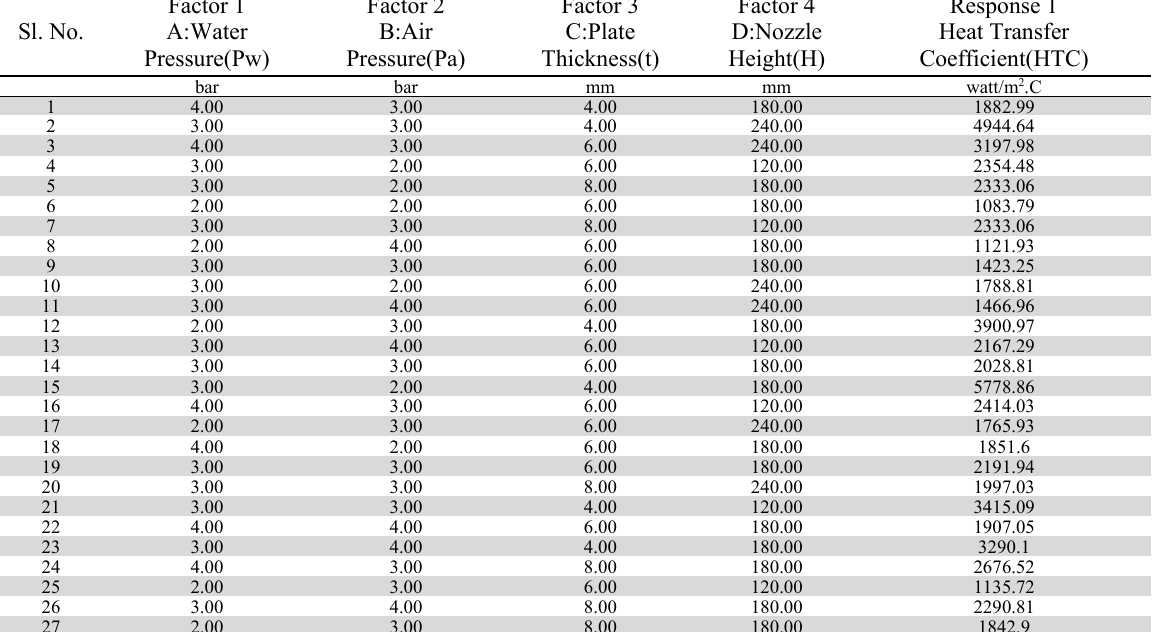
Magnitude of the outcomes Factor 1 Sl.